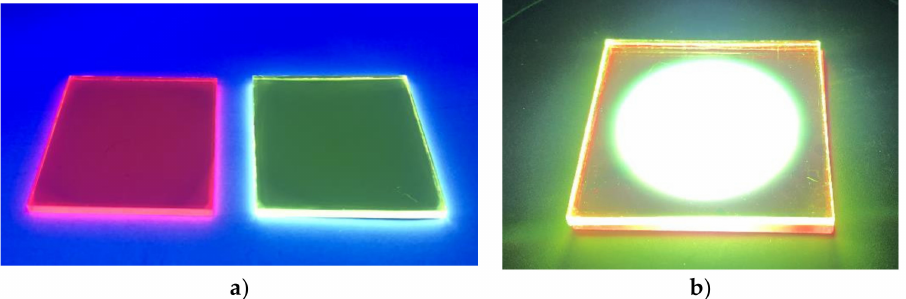
Figure 9. ( a ) Photoluminescent red-emitting and green-emitting converters embedded in a PMMA matrix and coated on glass under exposure to blue light. ( b ) White light emitted by the WLED-11-I